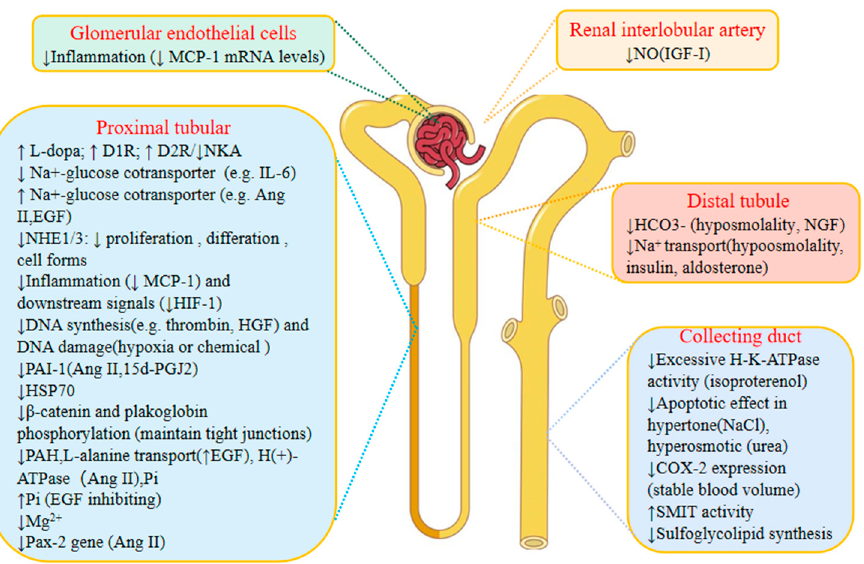
Figure 2. The effects of genistein on endothelial cells. MCP-1: monocyte chemoattractant protein-1; L-dopa: l-dihydroxyphenylalanine; DIR: D1 receptor; D2R: D1 receptor; EGF: epidermal growth fac- tor; NHE: Na+/H+ exchanger; HIF-1: hypoxia-inducible factor 1; HGF: hepatocyte growth factor;